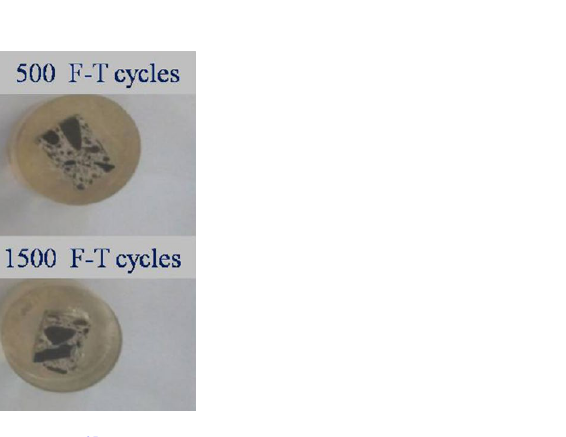
Figure 1. Polished samples with different F–T cycles 25